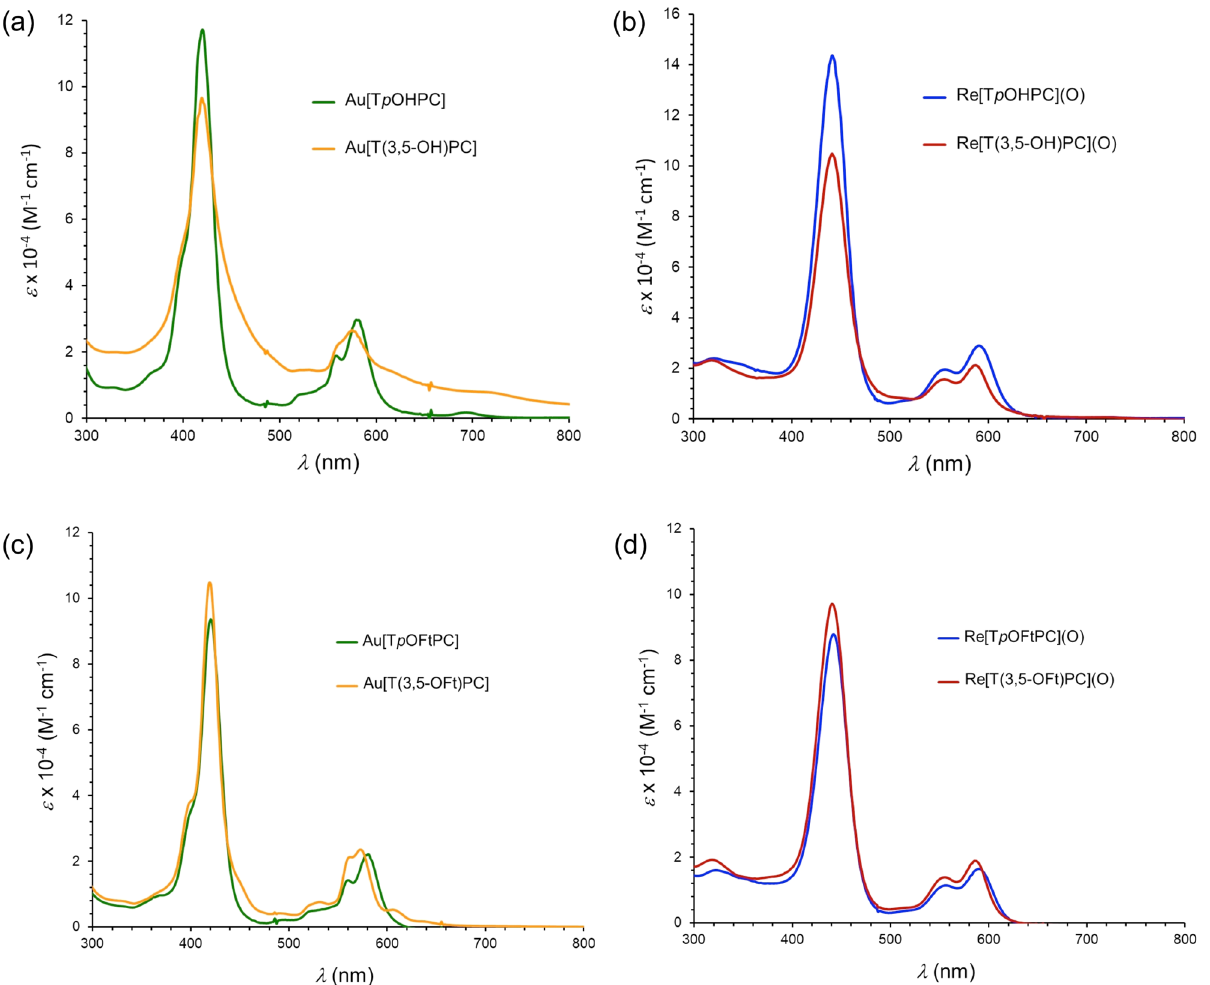
Figure 4. UV–vis spectra of new compounds prepared in this study. Phenolic and fluorous-tagged metallocorroles were analyzed in THF and dichloromethane (with a drop of hexafluorobenzene), respectively. Sample concentrations were in the 10–20 μM